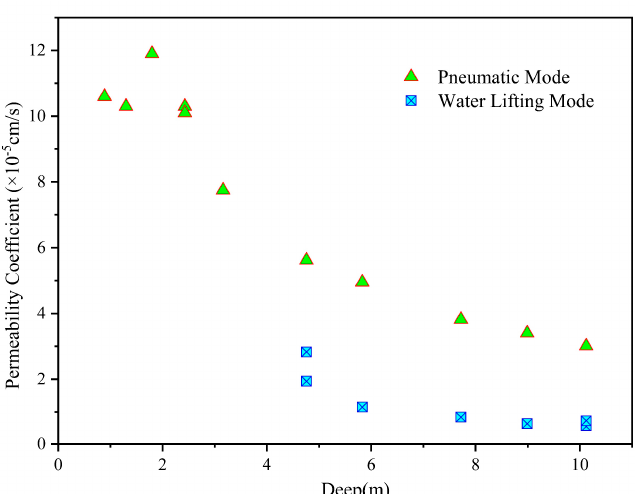
Figure 8. Calculation results of slug tests in different section positions. Table 4. Calculation result statistics of slug tests.